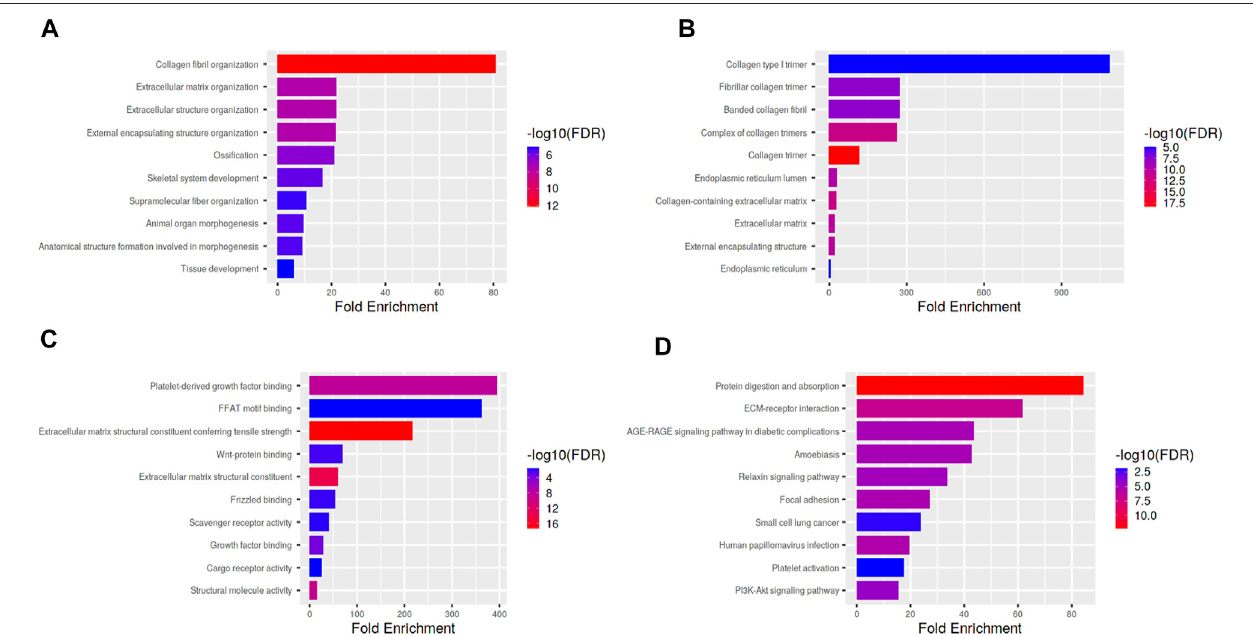
FIGURE8 | Enrichment analysis ofthe Kyoto Encyclopedia ofGenesand Genomes functionalpathways ofCTHRC1 and their related proteins using ShinyGO. (A) GOenrichmentanalysisofCTHRC1inbiologicalprocessofCOAD. (B) GOenrichmentanalysisofCTHRC1incellularcomponentsofCOAD. (C) GOenrichmentanalysis of CTHRC1 in molecular function of COAD. (D) KEGG pathway enrichment analysis of CTHRC1 in